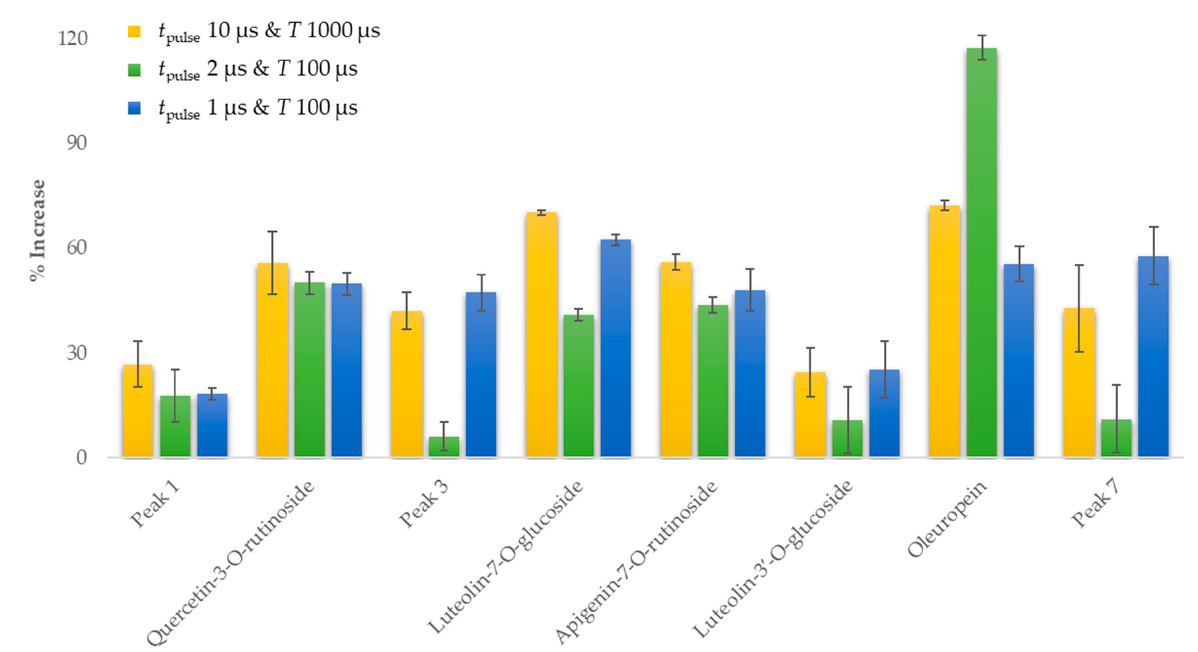
Figure 3. Percentage increases for the main compounds on the three best combinations of t pulse and T .